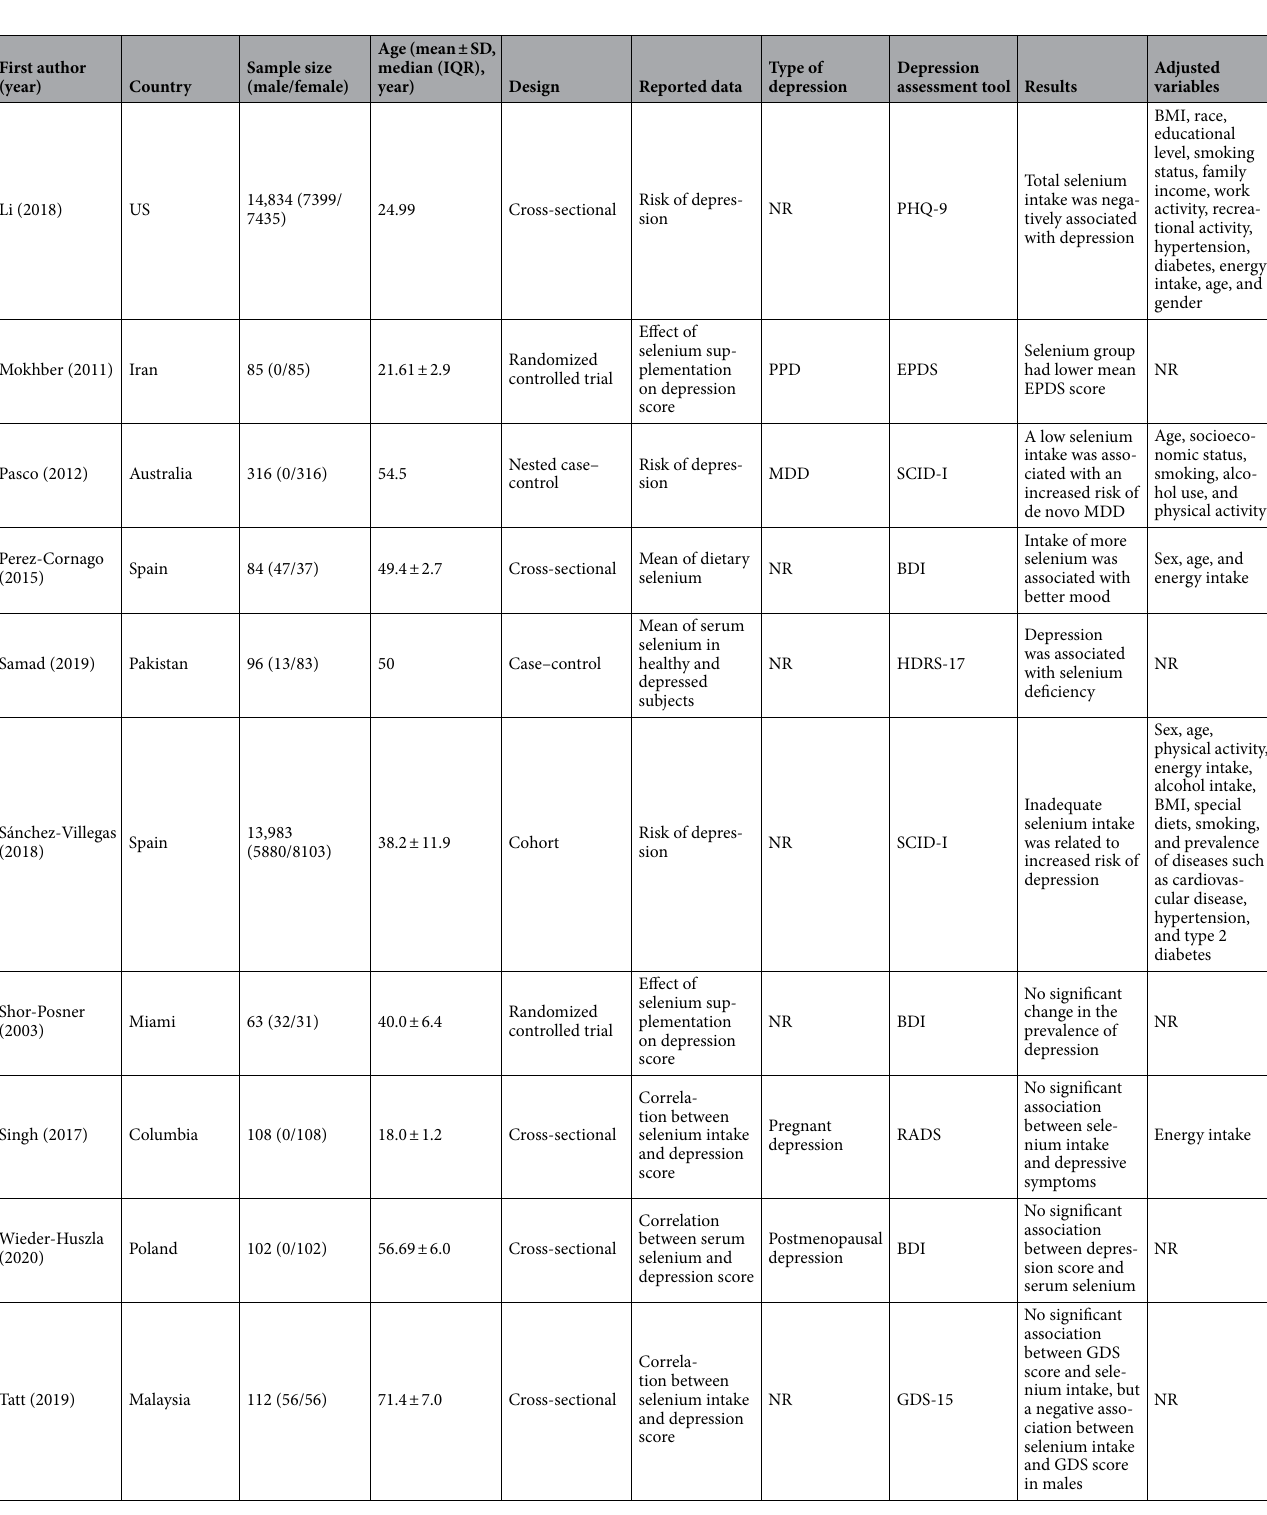
Table 1. Overview of the studies included in the systematic review. NR: Not reported, BMI: Body mass index, MDD: Major depressive disorder, PPD: Postpartum depression, EPDS: Edinburgh Postnatal Depression Scale, CESD: Center for Epidemiological Studies–Depression, BDI: Beck Depression Inventory, MADRS: Montgomery-Asberg Depression Rating Scale, HDRS-17: 17-item Hamilton Depression Rating Scale,